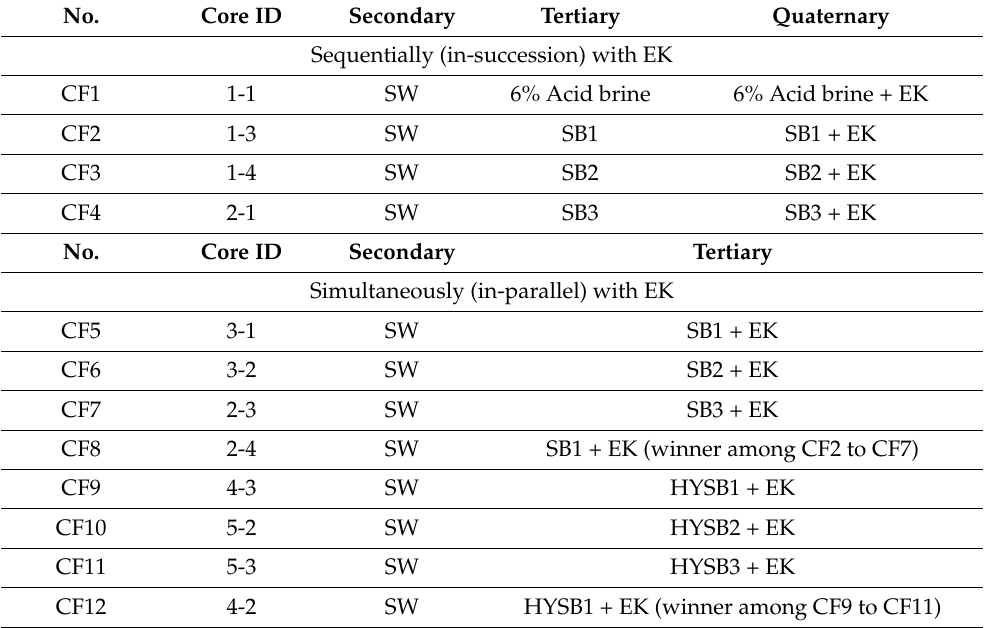
Table 7. Summary of coreflooding strategies. No.